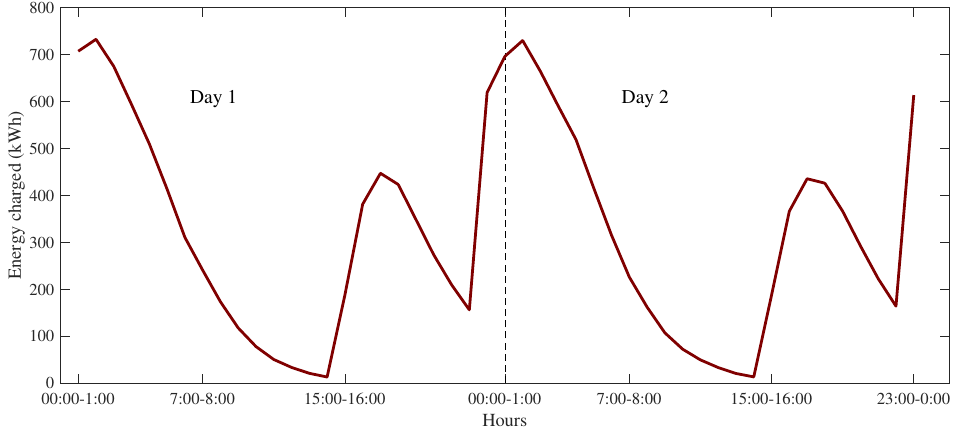
Figure 8. Example of charging profiles of EVs. Figure 9 represents the generated charging profiles for each characteristic day in each